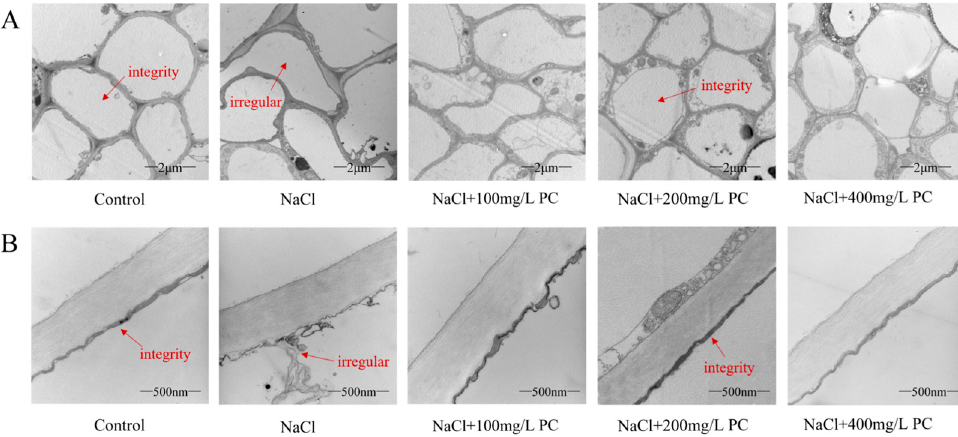
Figure 4. Transmission electron micrograph of peach tree root cells and cell membranes. ( A ) Root cell integrity. Bars correspond to 2 µ m; ( B ) Root cell membrane integrity. Bars correspond to 500 nm. The red arrows in the NaCl-treated figures represent irregular cells and cell membrane structures. The red arrows in the control and NaCl + 200 mg/L PC-treated figures indicate intact cells and cell membrane structures. Measurements were performed using the root tips of peach plants. The data were sampled at 11:00 am on the 11th day after the salt stress treatment.